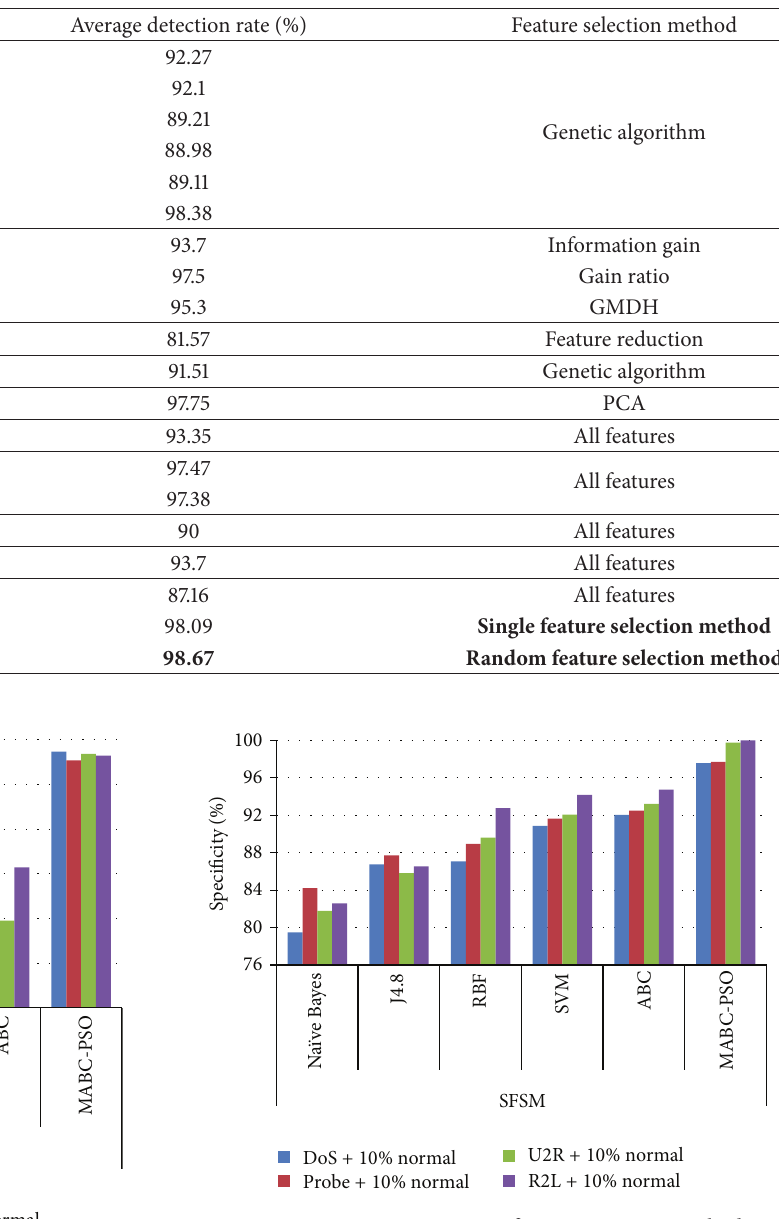
Figure 9: Comparison on specificity using SFSM